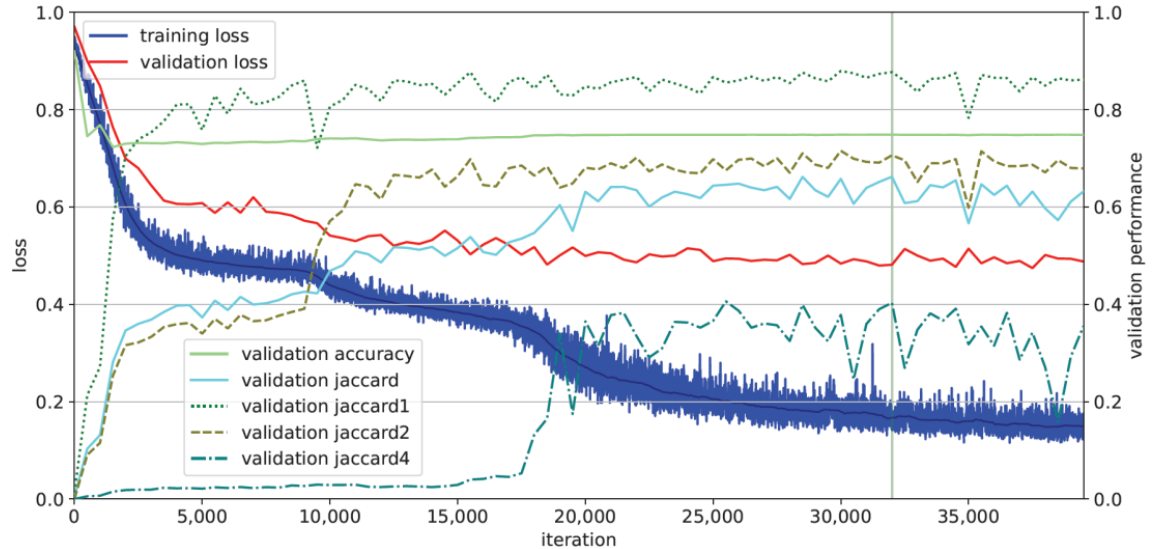
Figure 2. Loss curves of training (blue) and validation (red), as well as validation Jaccard scores (turquoise = mean of all; 1/dotted = segmentation of glottis; 2/dashed = segmentation of vocal cords; 4/dashed and dotted = detection of aspiration), show overlaps with the references. The vertical line shows the moment of the optimally working model.